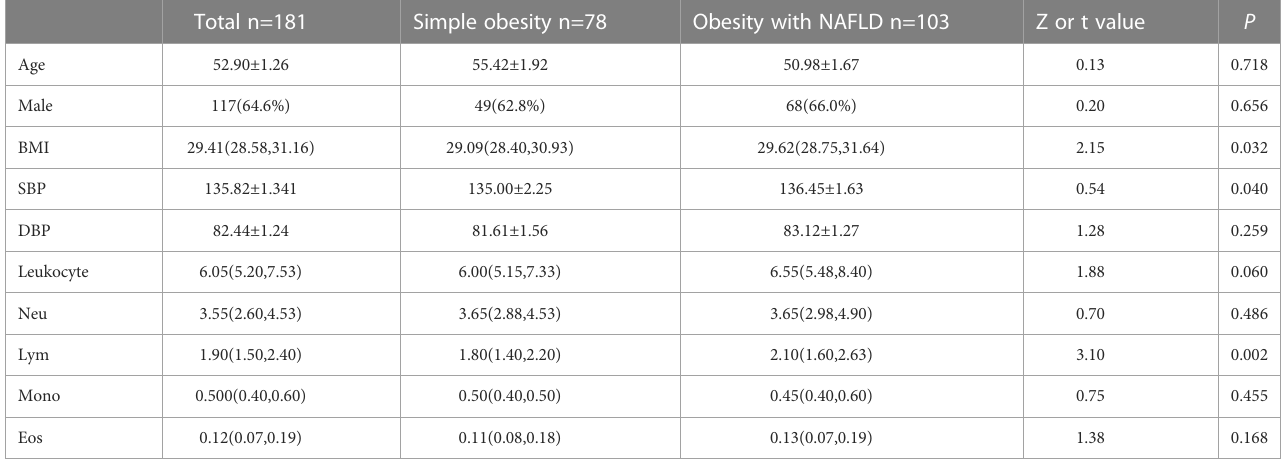
TABLE 1 Comparison of general data of obesity with NAFLD and simple